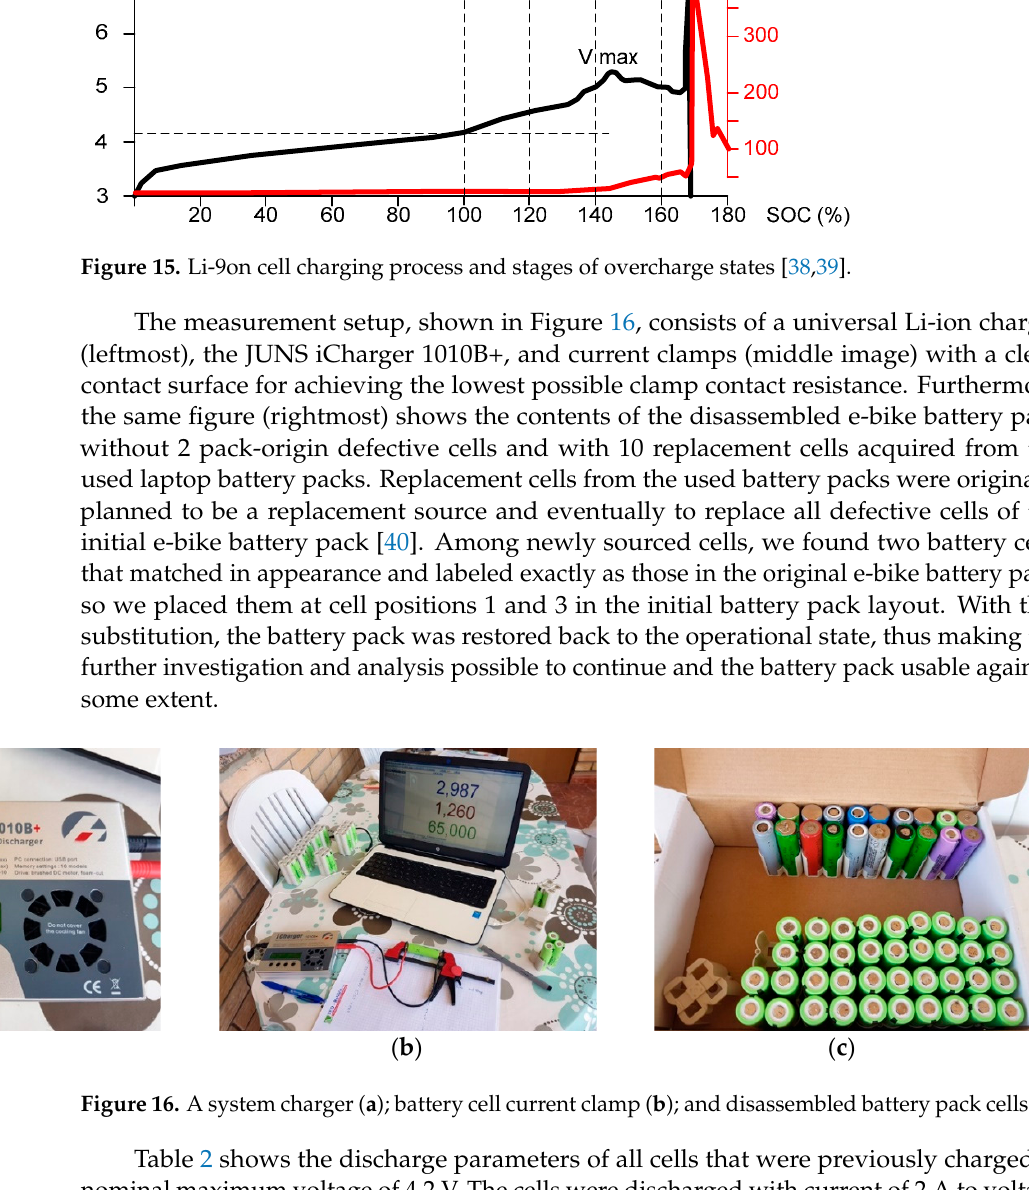
Table 2. Battery pack cell parameter values during 2 A discharge. Cell No.